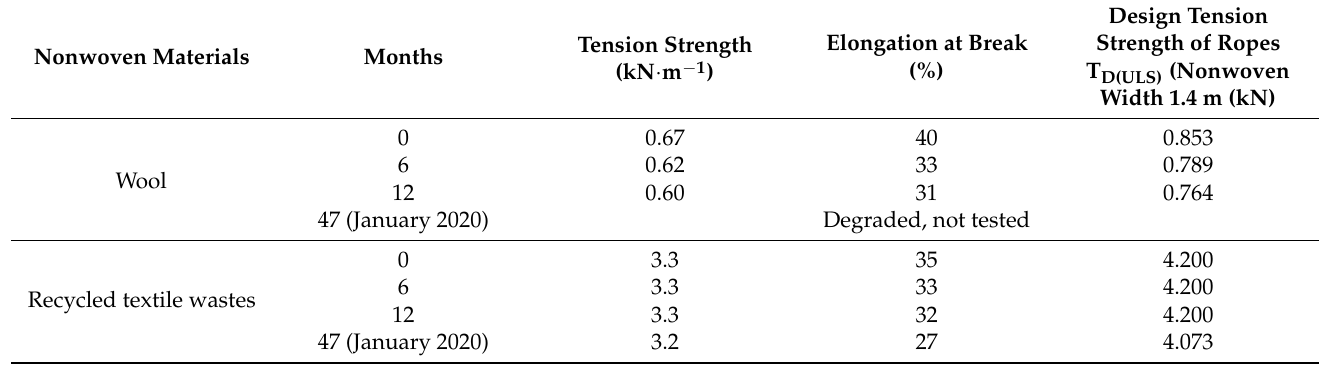
Table 5. Properties of the textile waste rope materials according to [24,25] (after 0, 6, and 12 months) and this research (location